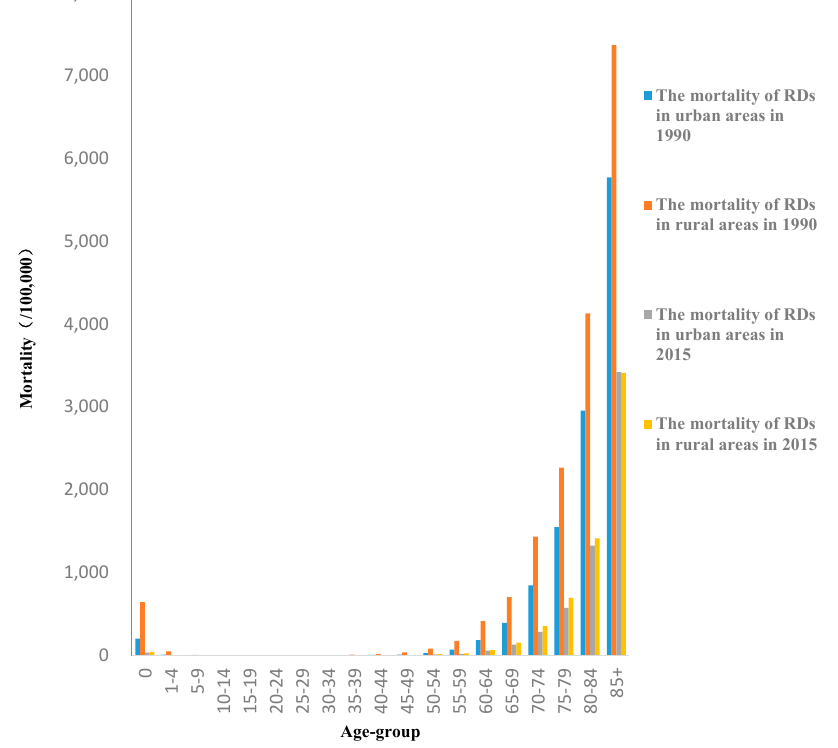
Figure 2. The age-specific mortality rates of CVDs in urban and rural areas in 1990 and 2015.